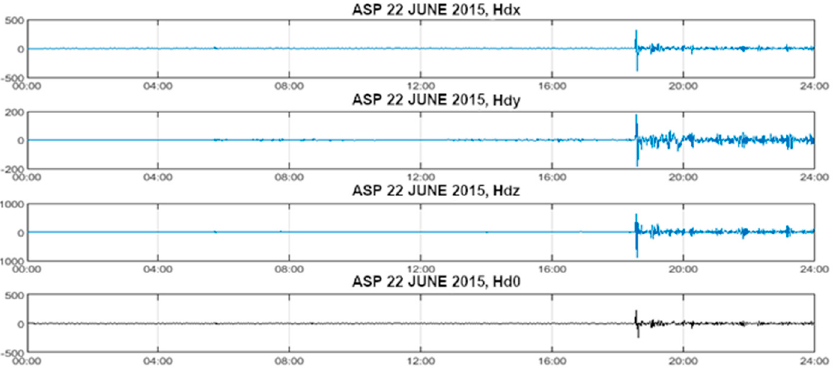
Figure 2. Results of calculating the derivatives of the components and the modulus of the geomagnetic field (nT/min), ASP observatory.